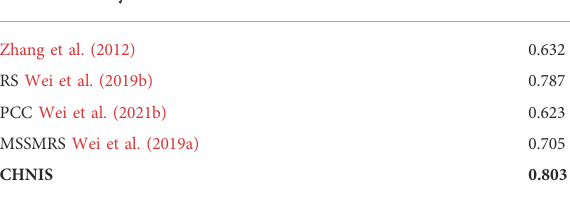
TABLE 7 Performance comparison of cold-hot nature evaluation. Related study